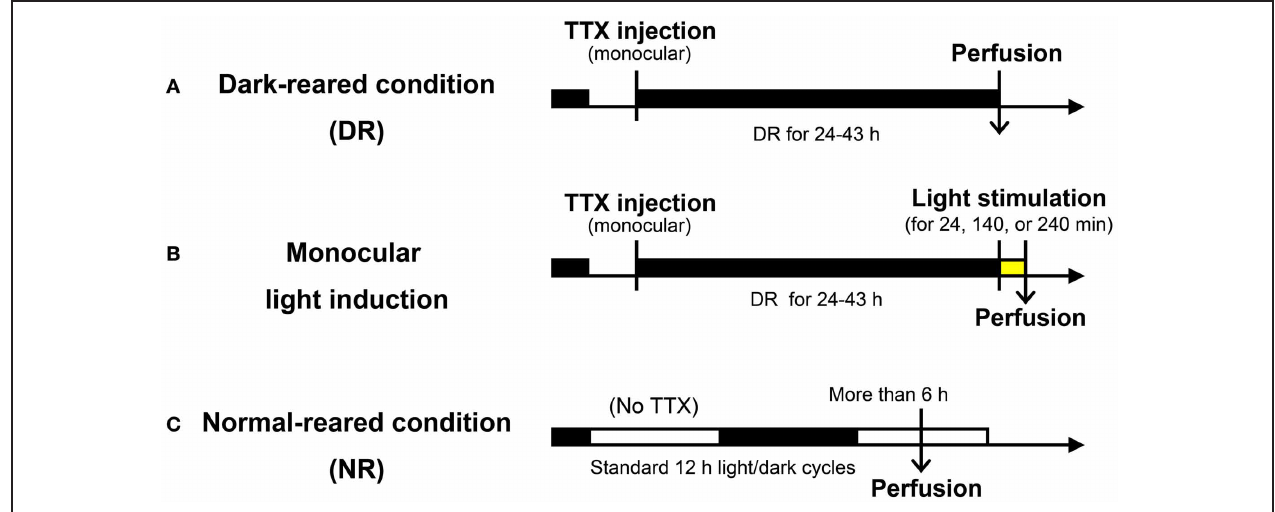
FIGURE 1 | Experimental procedure used for light induction experiments. (A) Dark-reared (DR) condition: following TTX injection into one eye, marmosets were kept in the dark for 24–43h before sacrifice. (B) Monocular light induction: following the same experimental procedure in (A) , light stimuli were given for 24, 140, or 240min before